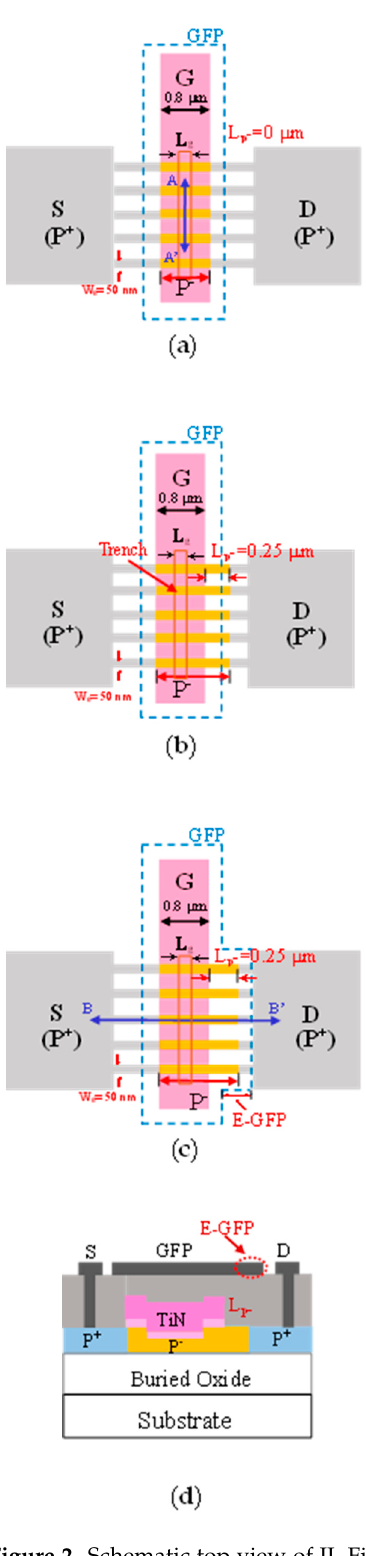
Figure 2. Schematic top view of JL FinTFT for ( a ) conventional structure with drain offset length ( L P − ) of 0 µ m. ( b ) Drain offset JL FinTFT without E–GFP and ( c ) drain offset JL FinTFT with E–GFP. ( d ) Cross–sectional view of drain offset JL FinTFT with E–GFP along B–B’ direction.